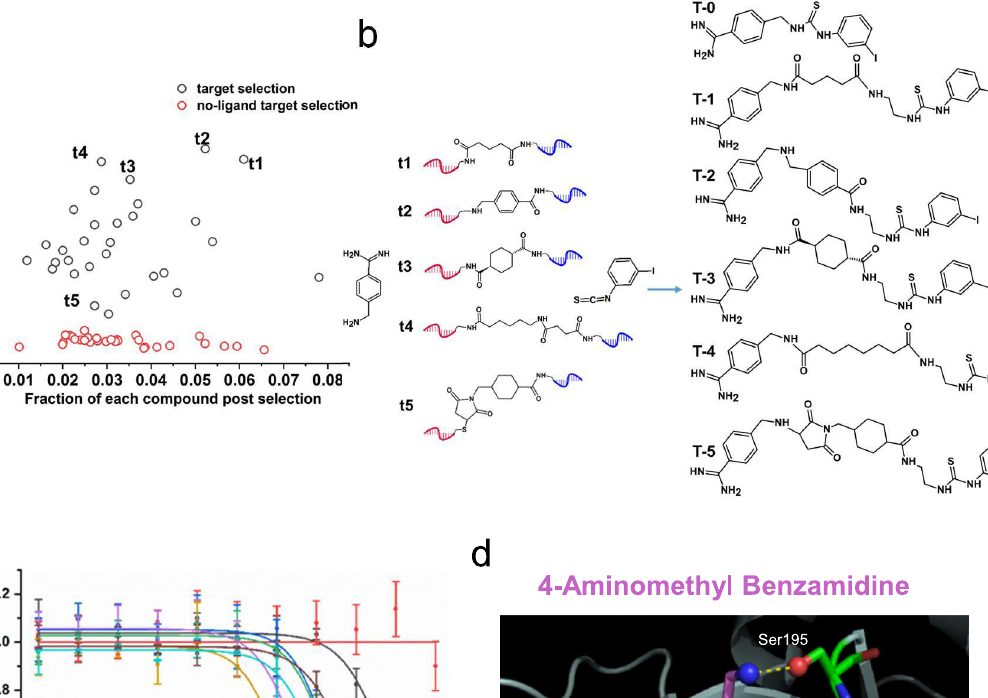
Fig.3|Af fi nitymaturationofligandpairagainstbovinetrypsin.a Scatterplotof the selection result. b Five conjugates (t1 to t5) enriched from the selection with varying enrichment folds were chosen to link 4-aminomethyl benzamidine and compound B, generating small molecules (T-1 to T-5) containing three moieties from the three sub-libraries. T-0 is a direct conjugation between 4-aminomethyl benzamidineandcompoundB. c Hitvalidationbyanenzymeinhibitionassay.Data are presented as mean values±SD from three independent measurements. IC 50 values are presented as mean values±SE. Data are presented as mean values±SD